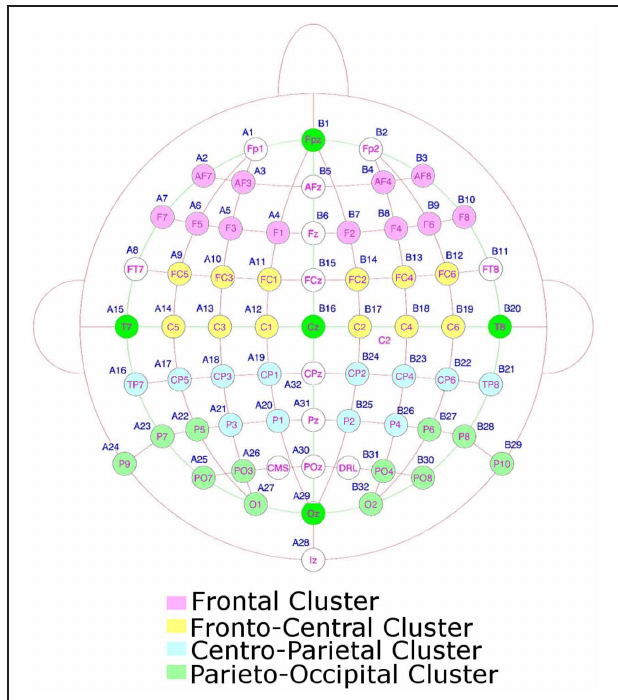
FIGURE 2 | The electrodes used to form the clusters for the statistical